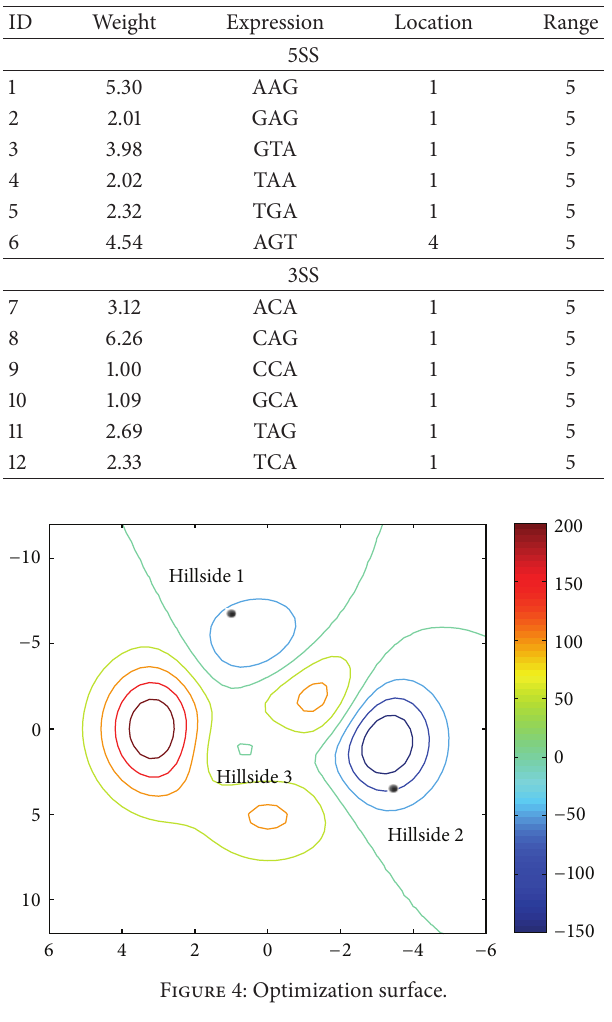
Figure 4: Optimization surface.